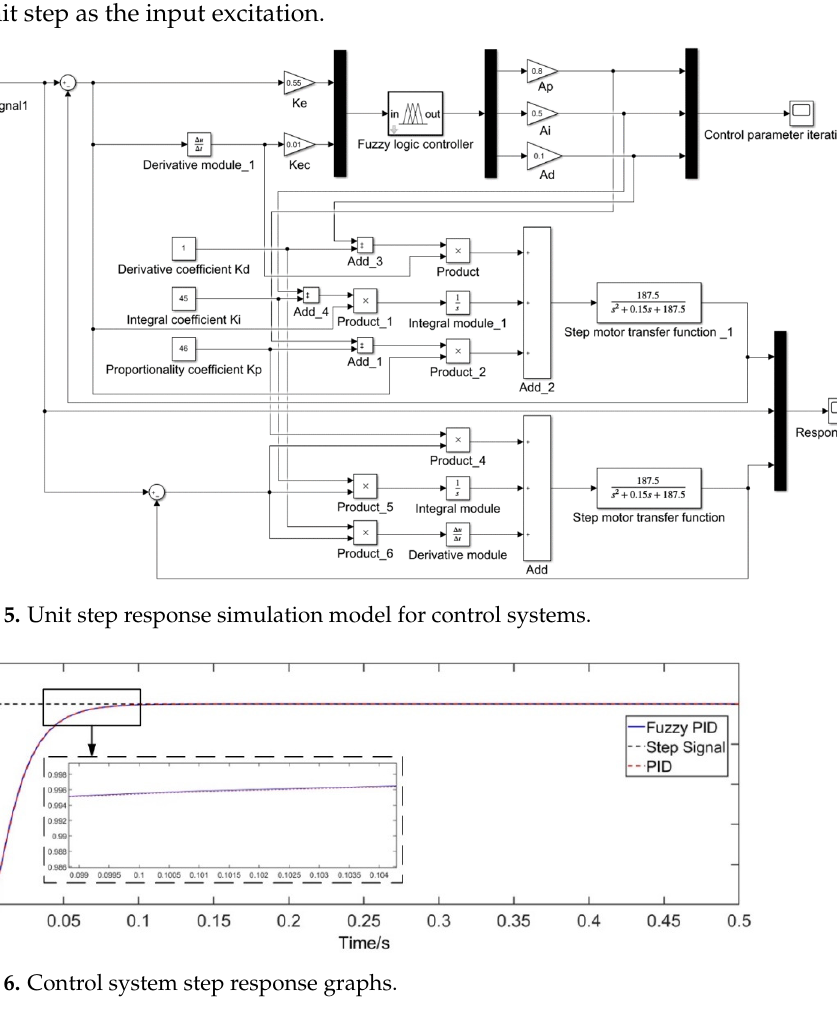
Figure 7. Simulation model of the control system after adding disturbances.